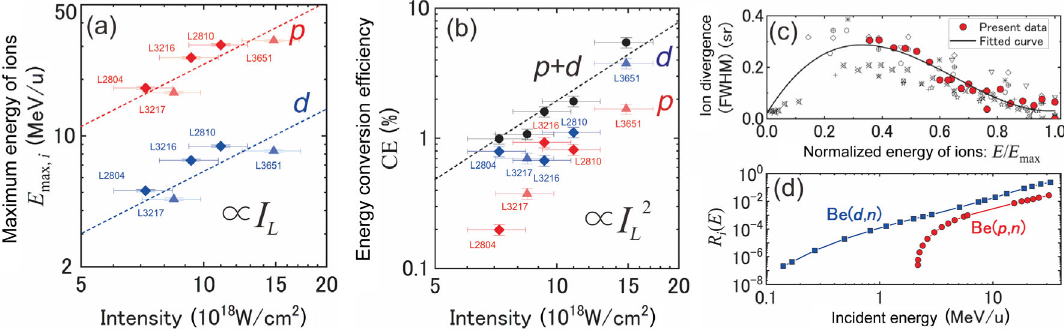
FIG. 2. (a) and (b) Experimental results of the maximum energy of ions ( E ) (a) and the energy conversion efficiencies (CE) max ;i from the laser to ions (b) as a function of the laser intensity for protons (red) and deuterons (blue). The results are measured with target foils of 1 and 5 μ m (triangles) and 5 μ m (rhombus) in thickness, respectively. The total CE for the protons and deuterons are shown as black circles in panel (b). The CE values are evaluated by using the total kinetic energy of the ions K [Eq. (5)] divided by the laser energy. (c) Divergence angle of ions measured as a function of the energy normalized by the maximum ion energy. The black symbols show results of previous works [23]. (d) Number of neutrons generated per one ion incident to sufficiently thick, solid Be blocks